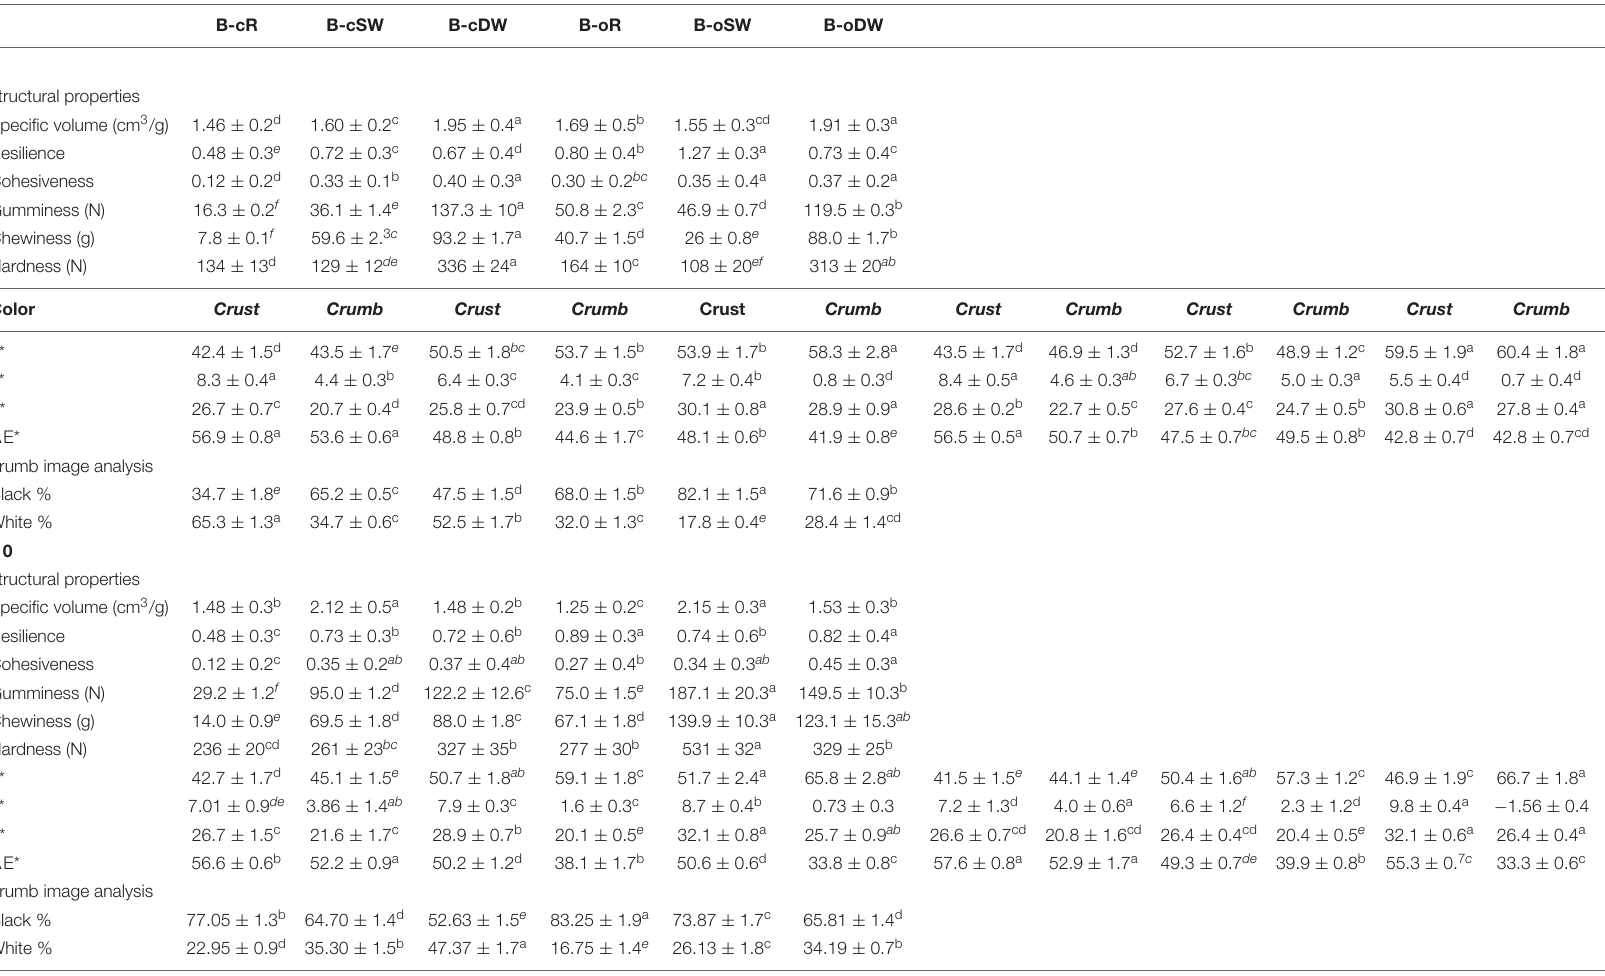
The sourdoughs were used as leavening agent at 15% and 40% (w/w) in wheat (DY, 160) and rye (DY, 180) breads, respectively. Lactiplantibacillus plantarum oR4 and DW9 strains were used as binary starters in association with Pediococcus acidilactici oSW5 to ferment conventional rye (oR4 and oSW5) and durum wheat (DW9 and oSW5) flours depending on the source of isolation of L. plantarum strains. Saccharomyces cerevisiae N2 was used as yeast in all samples. Bacteria and yeast were inoculated at final cell density of circa 7 and 6 log10 cfu/g, respectively. The first fermentation (t1) was carried out at 25 ◦ C for 24 h and propagation, through back-slopping (25 ◦ C for 5 h), and lasted 10 days. The data are the means of three independent experiments ± standard deviations (n = 3). a − e Values in the same row with different superscript letters differ significantly (p <